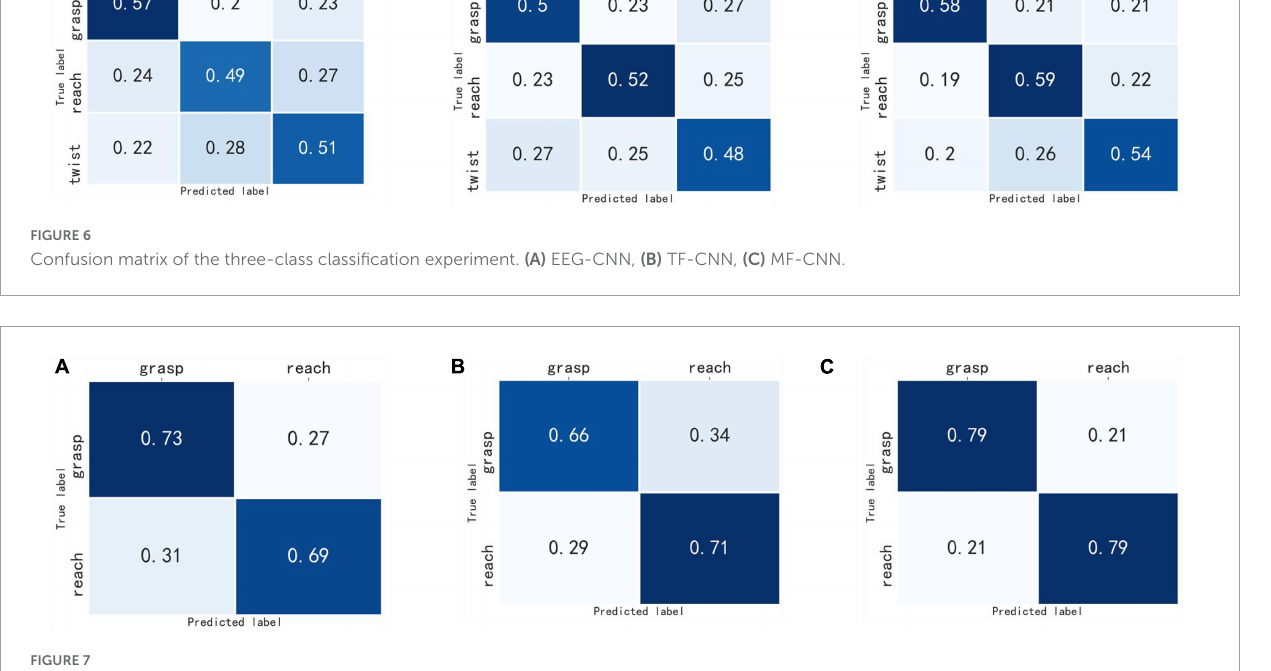
Frontiers in Neuroscience